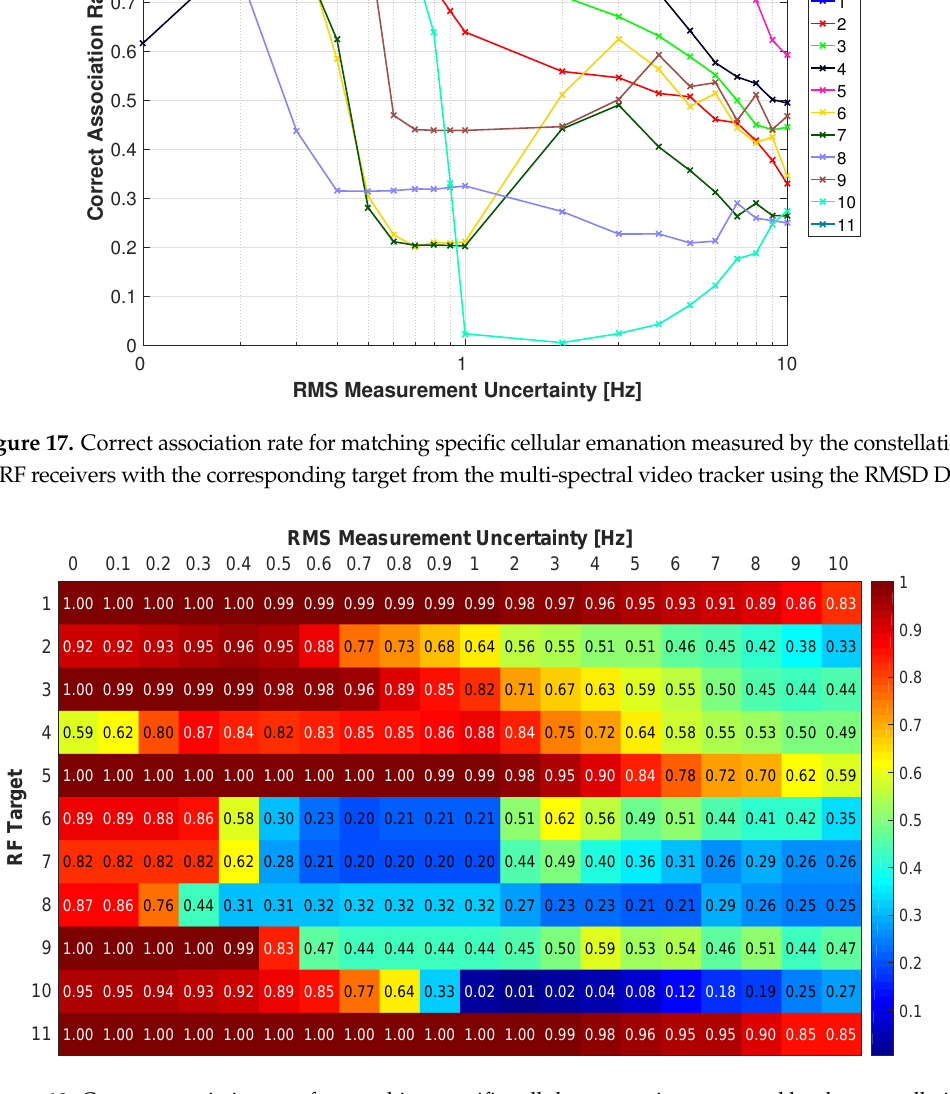
Figure 18. Correct association rate for matching specific cellular emanation measured by the constellation of RF receivers with the corresponding target from the multi-spectral video tracker using the RMSD